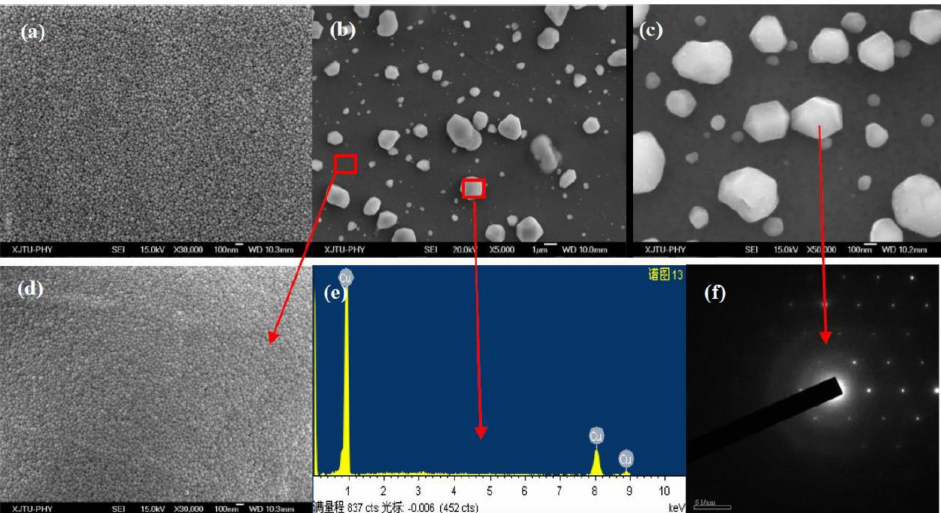
Figure 5. Field emission scanning electron microscope (FE-SEM) images of the surface morphology of the as-deposited and annealed Cu–Zr alloy films, and the selected area electron di ff raction (SAED) patterns of a Cu particle. ( a ) Cu-7.3%Zr deposited film, ( b ) Cu-7.3%Zr film annealed at 300 ◦ C, ( c ) Cu-17.1%Zr film annealed at 300 ◦ C, ( d ) the high magnification image of the surface morphology in the nearby regions without self-formation Cu particles in ( b ), ( e ) the energy dispersive spectrometry (EDS) pattern of a self-formation faceted particle in ( b ), ( f ) the SAED patterns of the self-formation faceted particles in ( c